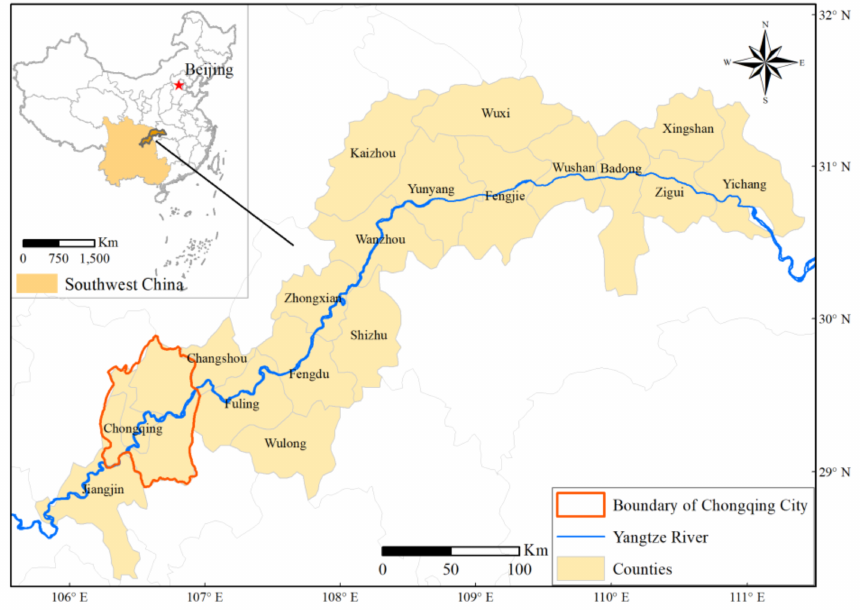
Figure 1. The study area and its location in Southwest